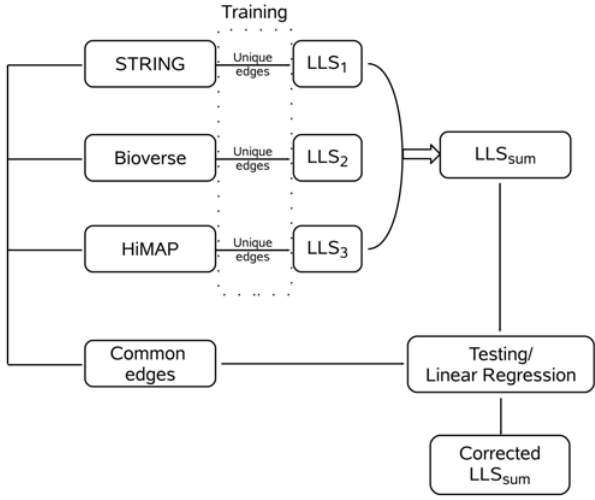
Figure 2. Diagram depicting the steps of log-likelihood score ( LLS ) calculation. Initially log-likelihood scores were calculated for each database independently. A naive Bayes classifier was applied to the individual data sets for mapping the interaction confidence onto a common scale. Subsequently a linear correction was applied to LLS obtained from more than one database.